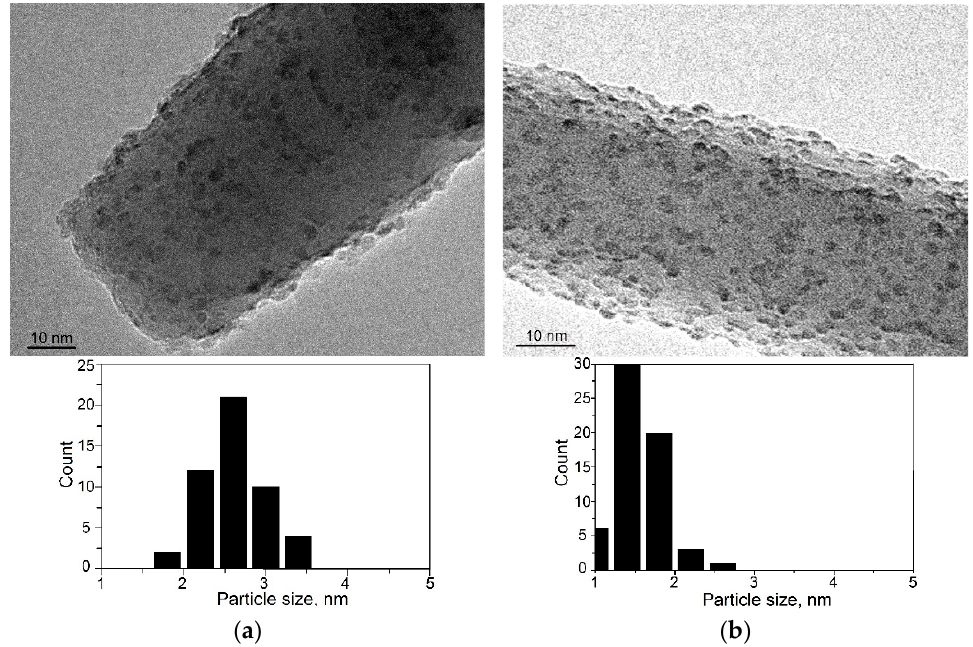
Figure 5. TEM images of the 1%Pd/ZnO ( a ) and 1%Pd-PVP/ZnO ( b ) catalysts and the Pd particle size distribution. size distribution.